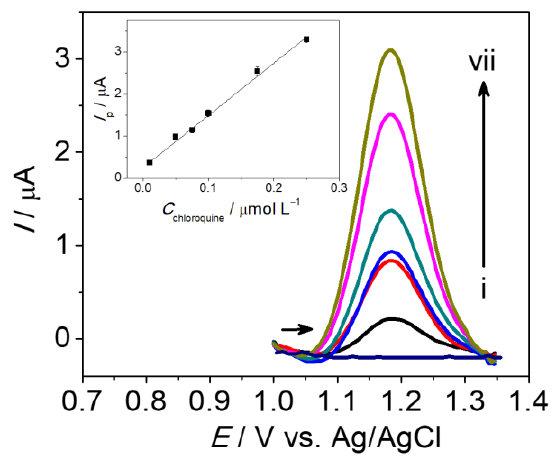
Figure 6. Square-wave voltammograms recorded using a cathodically pretreated BDD electrode for different concentrations of chloroquine in 0.1 mol L −1 Britton–Robinson buffer solution (pH 6.0): (i) blank (purple); (ii) 0.01 (black); (iii) 0.05 (red); (iv) 0.075 (blue); (v) 0.10 (green); (vi) 0.20 (pink); and (vii) 0.25 (yellow) µmol L −1 . SWV parameters: f = 100 Hz, A = 50 mV, and Δ E = 5 mV. Inset: Corresponding analytical curve ( I p vs. C Chloroquine ).